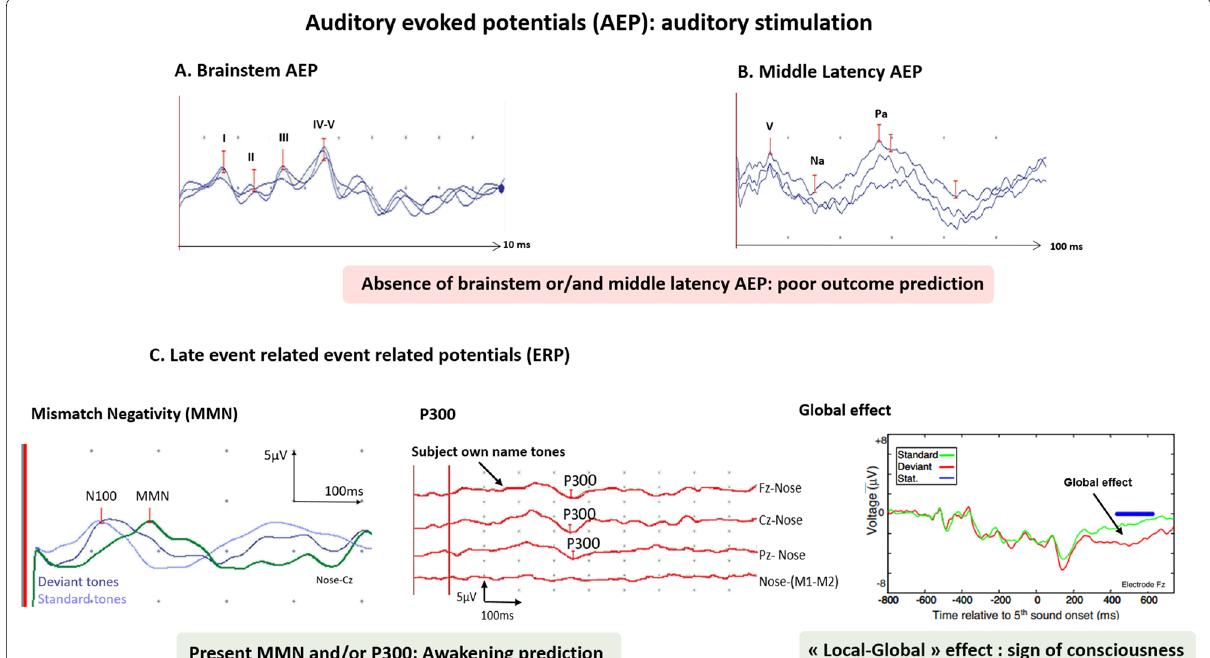
Fig. 4 Auditory evoked potentials interpretation and prognostic value in comatose and DoC patients after CA. Pre‑requisite for ERP interpretation: presence of BAEP, MLAEP and N100 (primary auditory cortices responses). Use of neuromuscular blockage agents is recommended if artefacts limit the recording. Part A Shows brainstem auditory evoked potentials (BAEP) (auditory nerves and brainstem integration of the auditory stimuli). Part B Shows middle latency auditory evoked potential (MLAEP). Part C Shows late auditory ERPs with Mismatch Negativity (MMN), P300 and “local– global” effect. MMN is elicited by an auditory passive “oddball” paradigm (series of standard frequent tones and deviant infrequent tones). MMN is obtained by subtracting the ERP of the deviant and standard tones. P300 is elicited by the same “oddball” paradigm with intermix of scarce